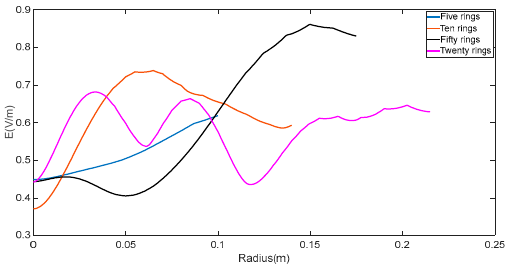
Figure 18. Radial profile of the electric field for a wet poplar sample with a 100% dielectric constant variation between growth rings. Dielectric constant values were used with 28% moisture content according to [27].